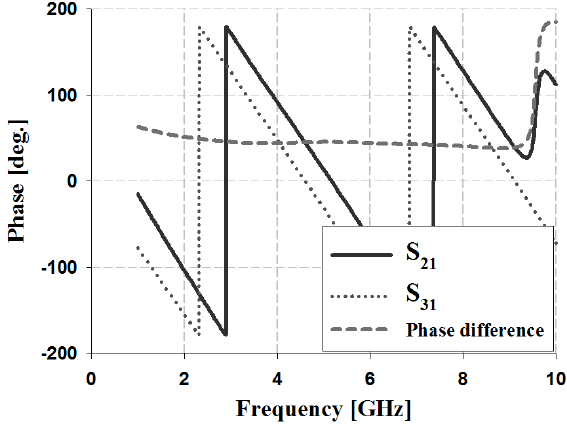
Figure 9. Phase and phase difference simulation analysis of the proposed shifter.